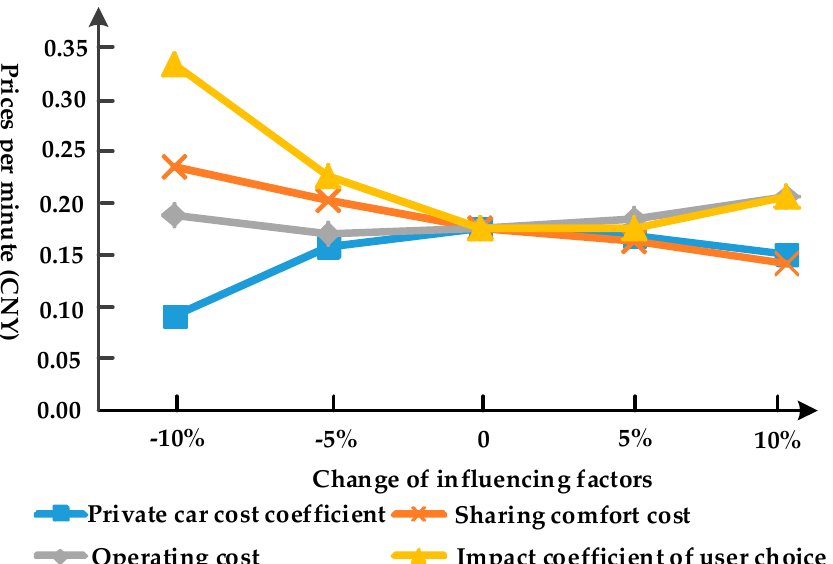
Figure 5. Curve of prices per kilometer.